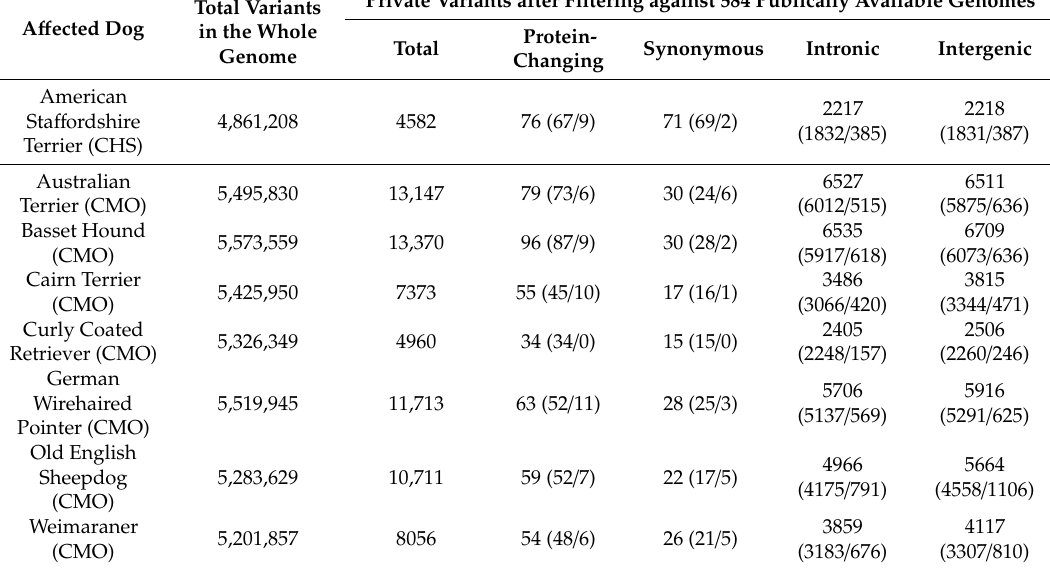
Table 1. Private variants detected in the individual genomes of the 8 a ff ected dogs and absent in the 584 comparison cohort genomes. The table gives total counts of private variants divided into classes on the basis of their predicted e ff ect. The counts of homozygous / heterozygous genotypes separately are shown in